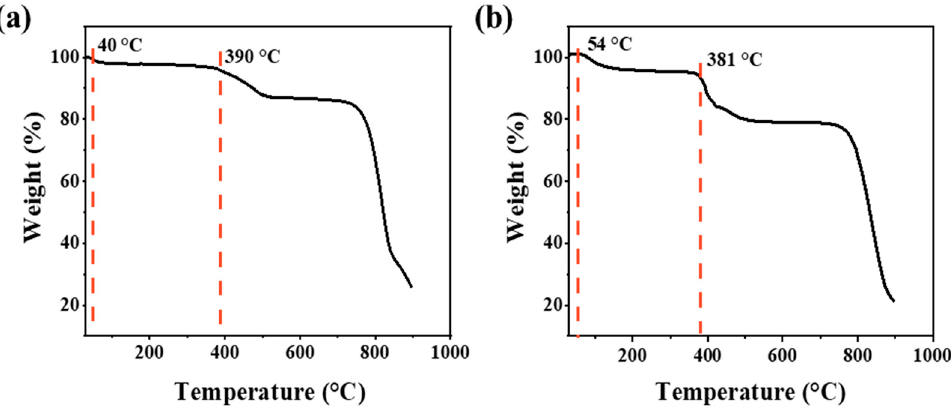
Figure 2. TGA curves of ( a ) MoS 2 and ( b ) 2RuO x /MoS 2